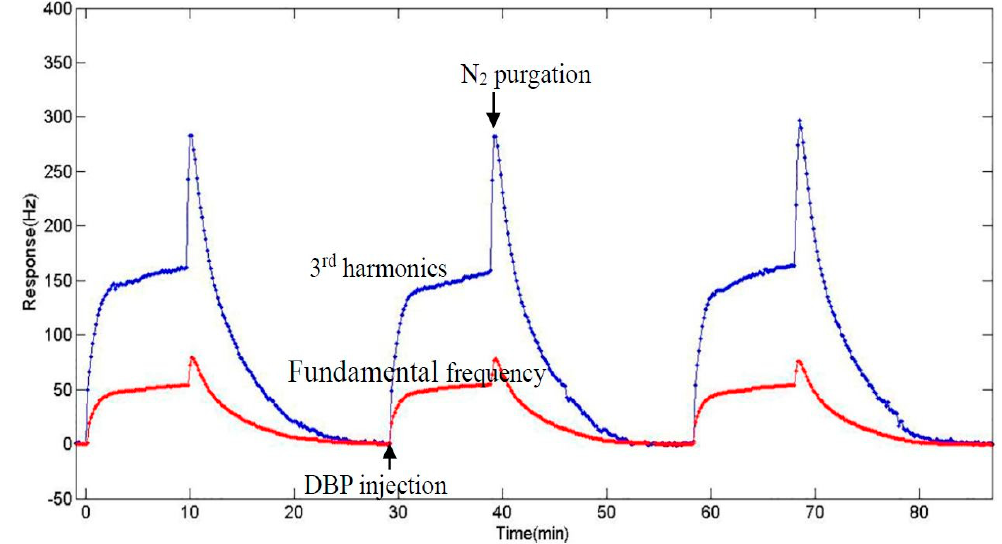
Figure 7. Responses of the nano-Ni(OH) 2 QCM sensor to 24 ppb DBP. The red line is the response when the quartz oscillator works at the fundamental frequency, while the blue one works at 3rd harmonics.